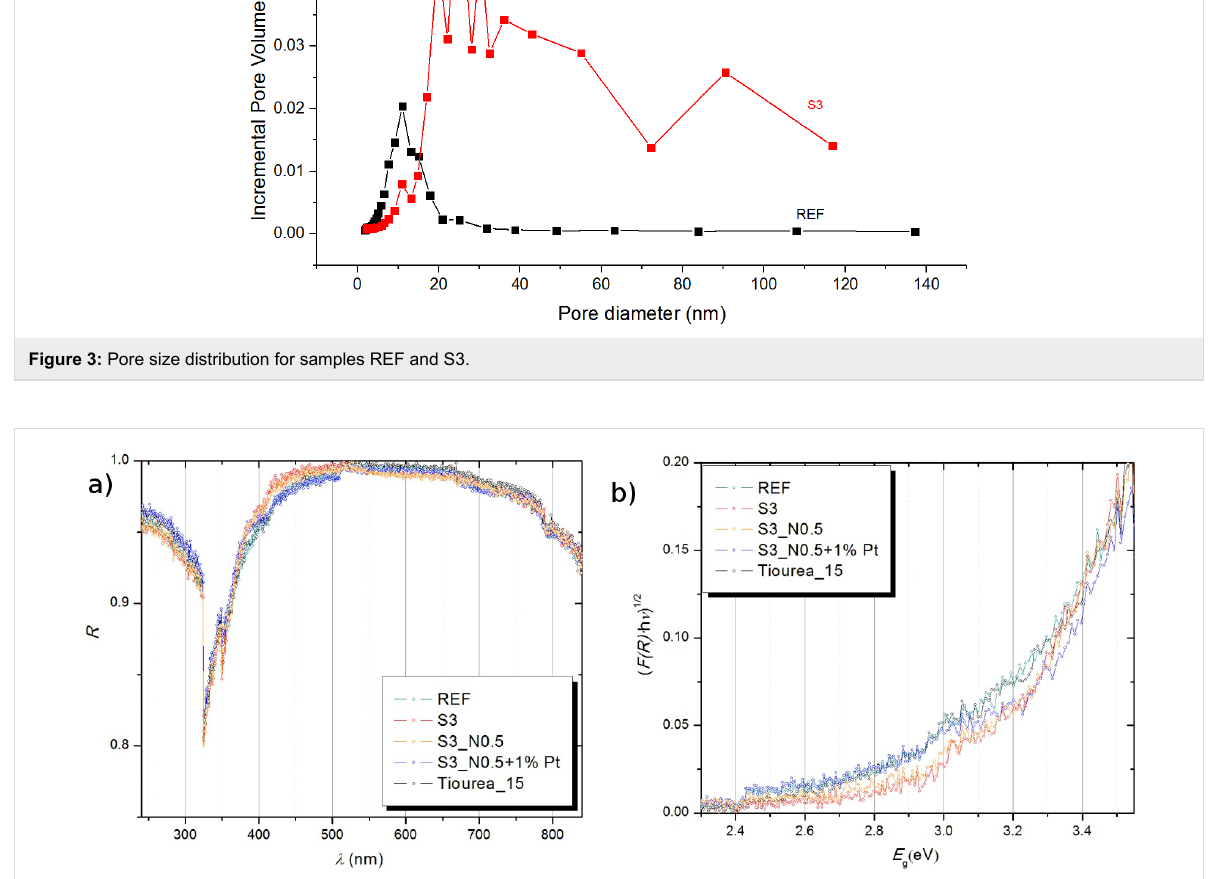
Figure 4: (a) Measured diffuse reflectance plotted as a function of the wavelength – R ( λ ) and (b) modified Kubelka–Munk function vs energy.